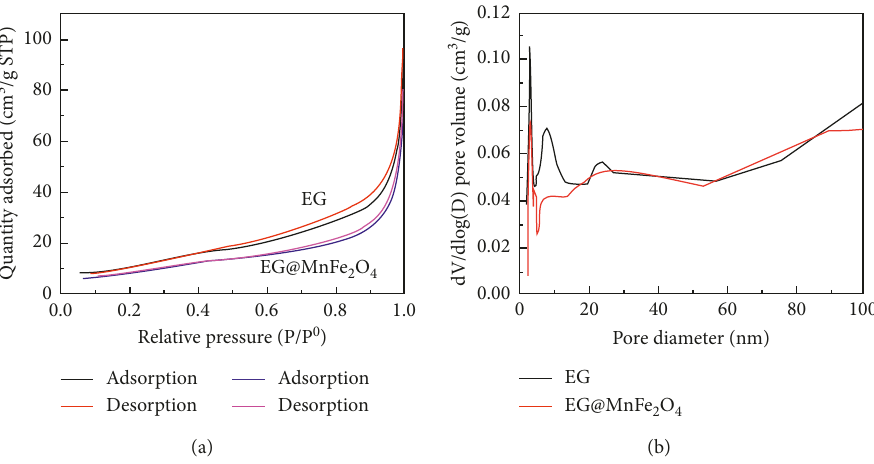
Figure 4: N 2 adsorption desorption isotherm measurement (a) and pore size distribution (b) plots of EG and EG@MnFe 2 O 4 materials.